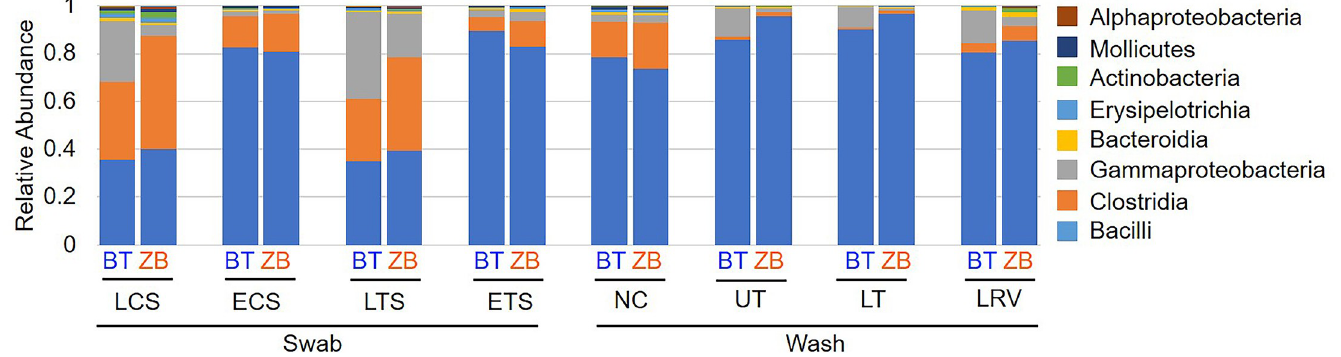
Fig 5. Comparison of relative abundances of different bacteria classes in samples extracted using the BT and ZB kits. LCS, live choanal swab; ECS, euthanized choanal swab; LTS, live tracheal swab; ETS, euthanized tracheal swab; NC, nasal cavity wash; UT, upper trachea wash; LT, lower trachea wash; LRV, lower respiratory